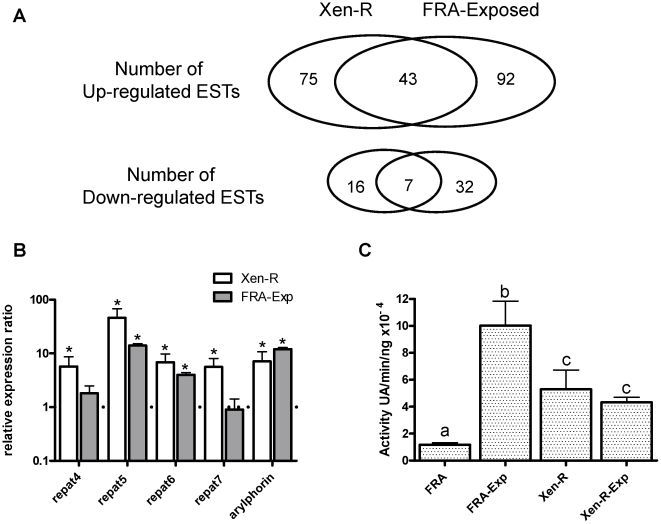
Overlapping characteristics between unexposed Xen-R and exposed FRA insects.A) Schematic representation of the distribution of ESTs differentially expressed in the Xen-R insects and ESTs that are regulated after exposure of FRA insects to Xentari™. B) Relative expression, measured by qRT-PCR, for the selected genes in the Xen-R unexposed insects and for the FRA insects exposed to Xentari™. Asterisks denote changes in expression that are significantly different from the expression in the unexposed FRA insects (t-test, p-value <0.05). C) Aminopeptidase activity found in the midgut lumen of the Xen-R and FRA insects with and without exposure to B. thuringiensis Cry1Ca toxin. Different letter denote statistically different values (t-test, p-value <0.05).